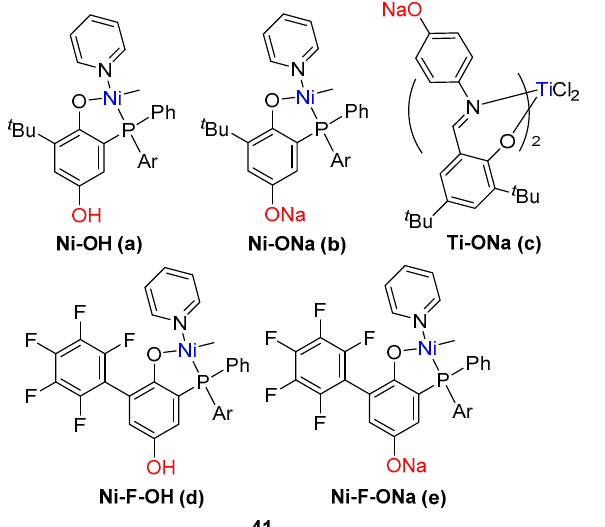
Figure 35. Hydroxyl-functionalized metal complexes 41a – e used in the heterogeneous system.